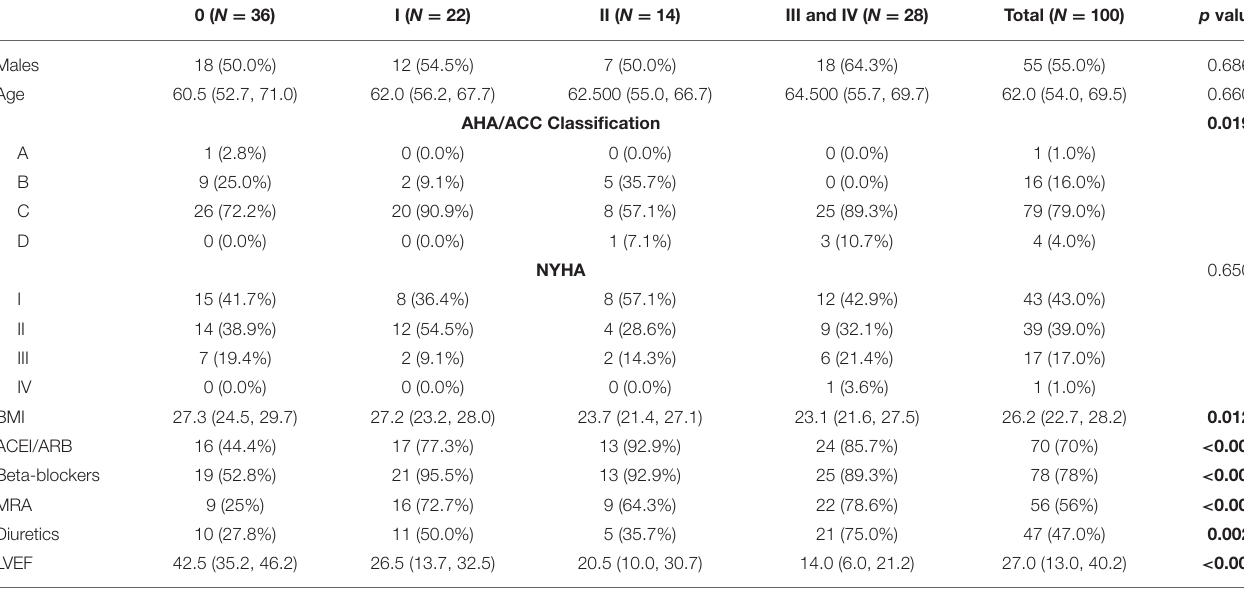
TABLE 2 | Characteristics of the patients with chronic Chagas cardiomyopathy evaluated according to diastolic dysfunction classification ( n =